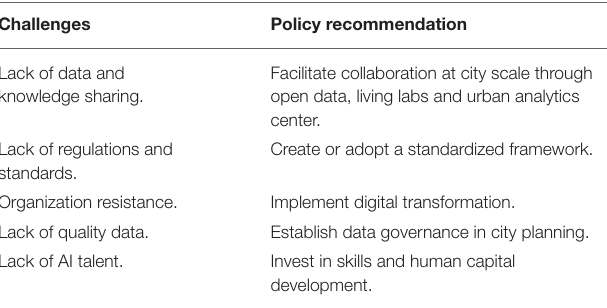
TABLE 1 | Challenges and policy recommendations for enhanced implementation of artificial intelligence for urban mobility.